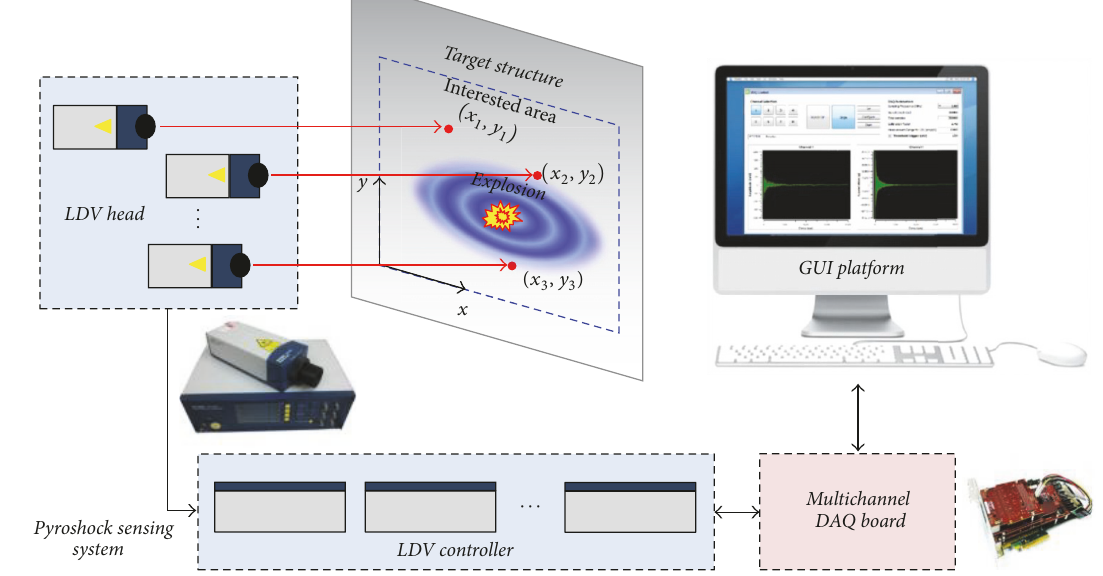
Figure 2: Pyroshock measurement process using a shock measurement system based on multiple laser Doppler vibrometers (LDVs).